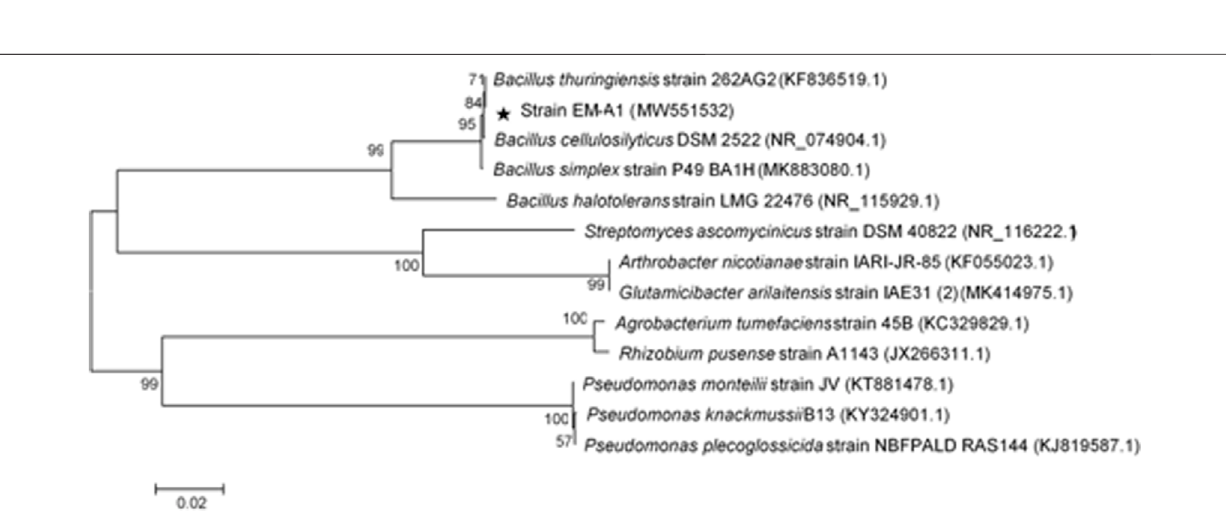
Frontiers in Environmental Science |